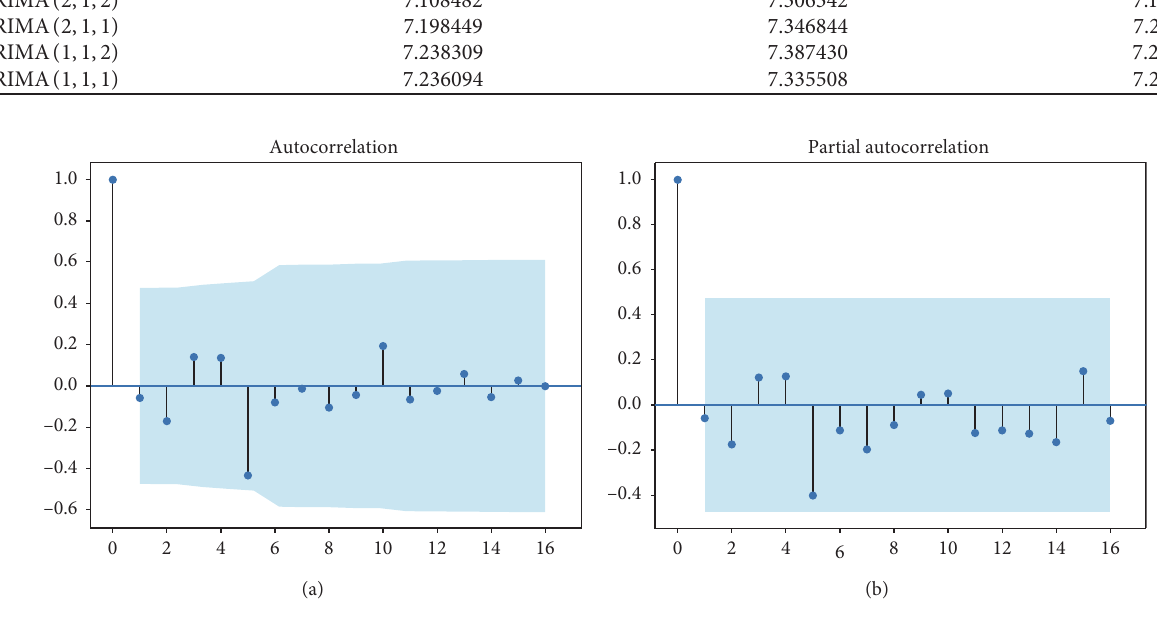
Figure 8: The correlation analysis of ARIMA ( 2 , 1 , 2 ) .